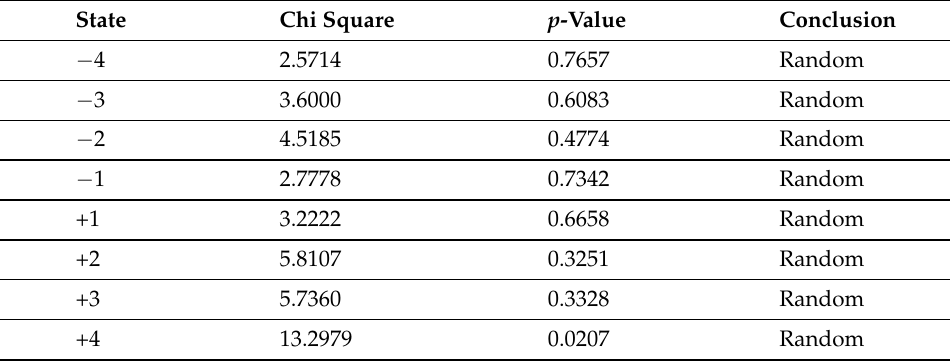
Table 7. NIST random excursion test on a third order Horadam